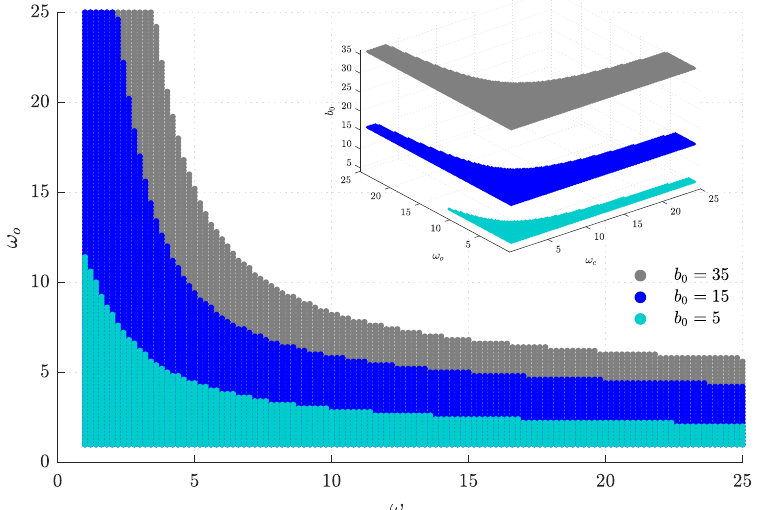
Figure 4. Closed loop stability regions for G e ( s ) . Each point in the region represents a combination of parameters producing a stable output. For each value of b 0 ∈ [ 5,35 ] there exist pairs ( ω c , ω o ) that produce a stable output. The b 0 = 5,15,35 values are plotted as examples to illustrate the shape and behavior of the stability